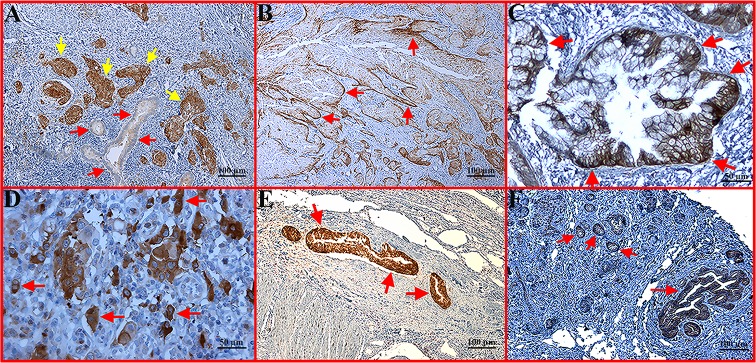
Immunohistochemical staining of PKM2 expression in representative pancreatic tumour sections.(A) Well differentiated area of tumour showing weak PKM2 expression (red arrow), with high expression in poorly differentiated areas (brown colour, yellow arrow) (x100 magnification). (B) Growing margin of tumour nodules with strong expression of PKM2 (red arrow) (x100 magnification). (C) Membranous expression of PKM2 (red arrow) (x200 magnification). (D) Heterogeneous expression of PKM2 with predominant expression in the proliferating cells (red arrow) (x200 magnification). (E) Strongly positive tumour expression of PKM2 in vascular invasion (red arrow) (x100 magnification). (F) Strongly positive tumour expression of PKM2 with muscular invasion (red arrow) (x100 magnification).